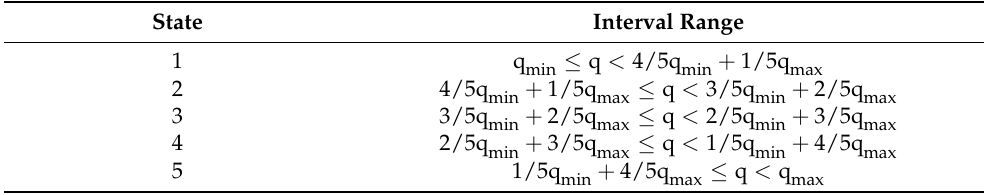
Table 3. State level division.